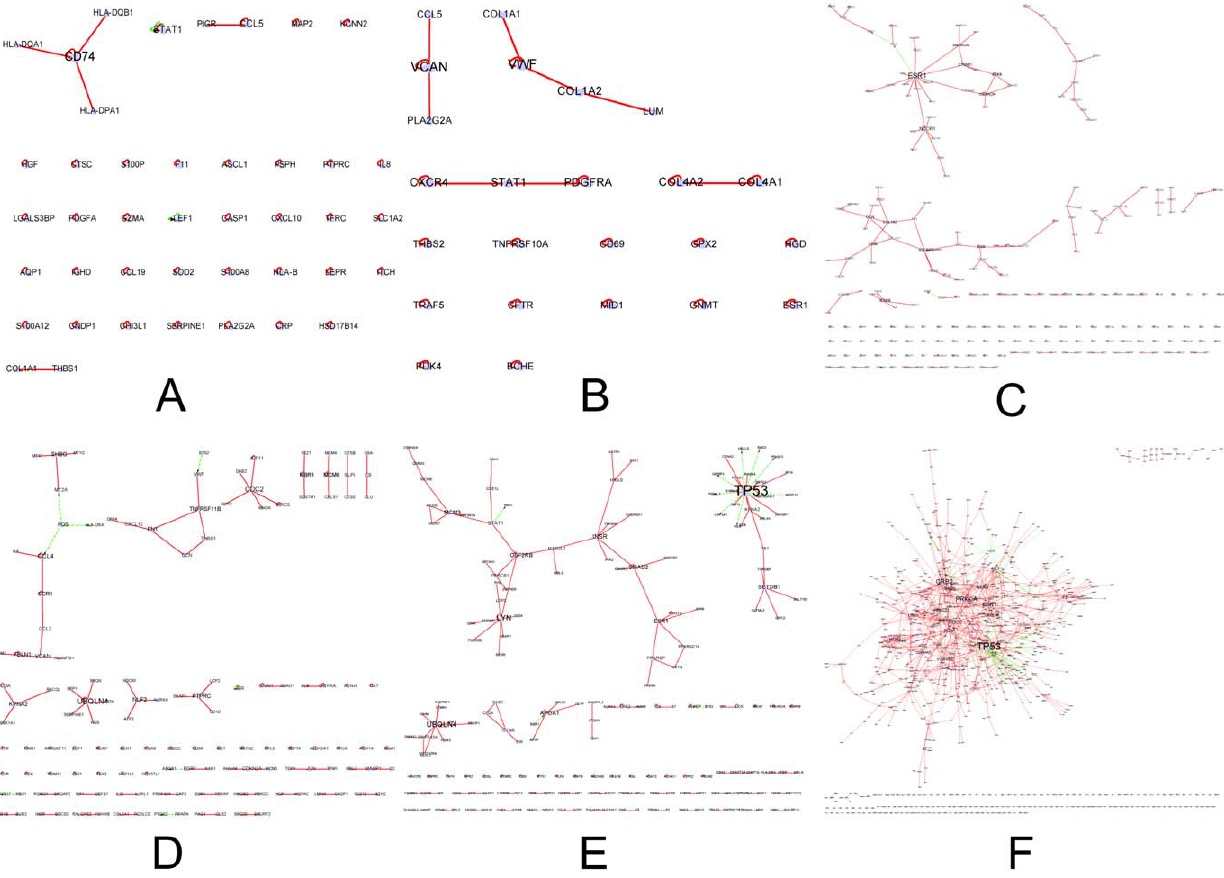
Figure 2. Sub networks identified in developing progression of HCV induced hepatocarcinogenesis. Edge color: red, PPI; green, TRI. Edge direction: undirected, PPI; directed, TRI, from transcriptional factor to target gene. (A) sub networks that were deregulated initially from hepatitis; (B) the ones that were deregulated initially from cirrhosis; (C) the ones that were deregulated initially form BCLC stage 0 HCC; (D) the ones that were deregulated initially form BCLC stage A HCC; (E) the ones that were deregulated initially form BCLC stage B HCC; (F)the ones that were deregulated initially form BCLC stage C HCC.